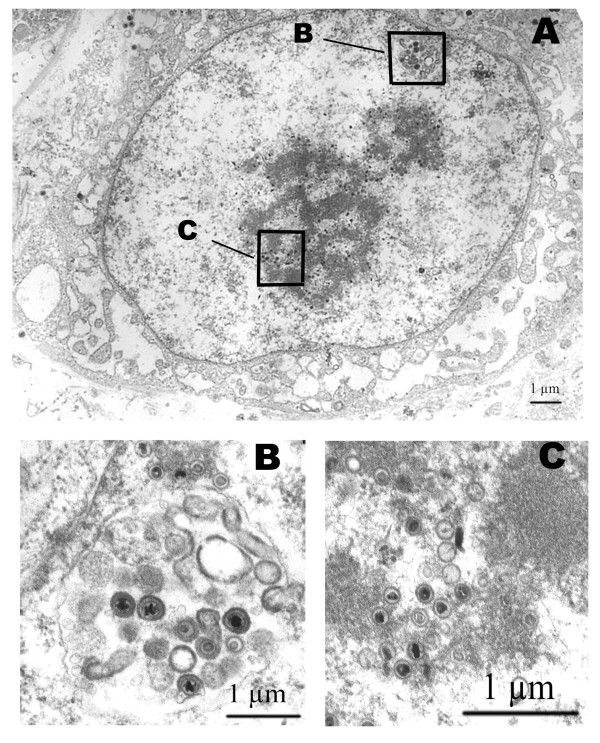
HCMV in human spermatogonium on Day 14 post infection in testis organotypic culture. Ultrathin section was obtained from HCMV-infected testis explants in organotypic culture on Day 14 post infection (A). Full and empty viral capsids (insert B) and virions (insert C) were demonstrated in the nucleus of spermatogonium.